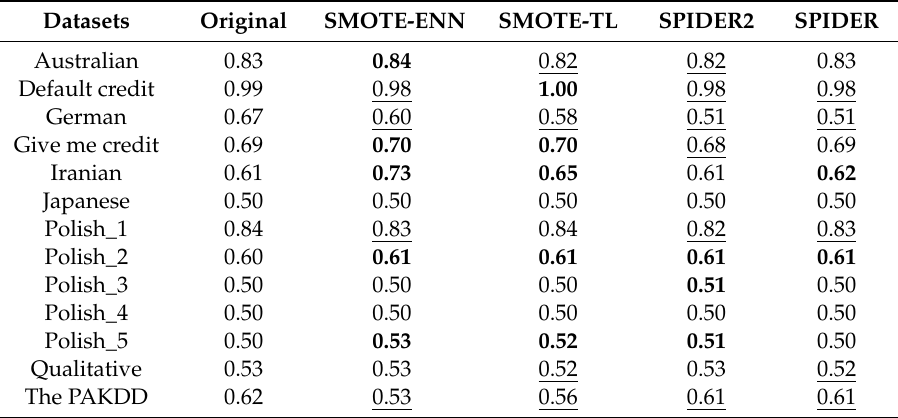
Table 17. AUC for NAC classifier after hybrid